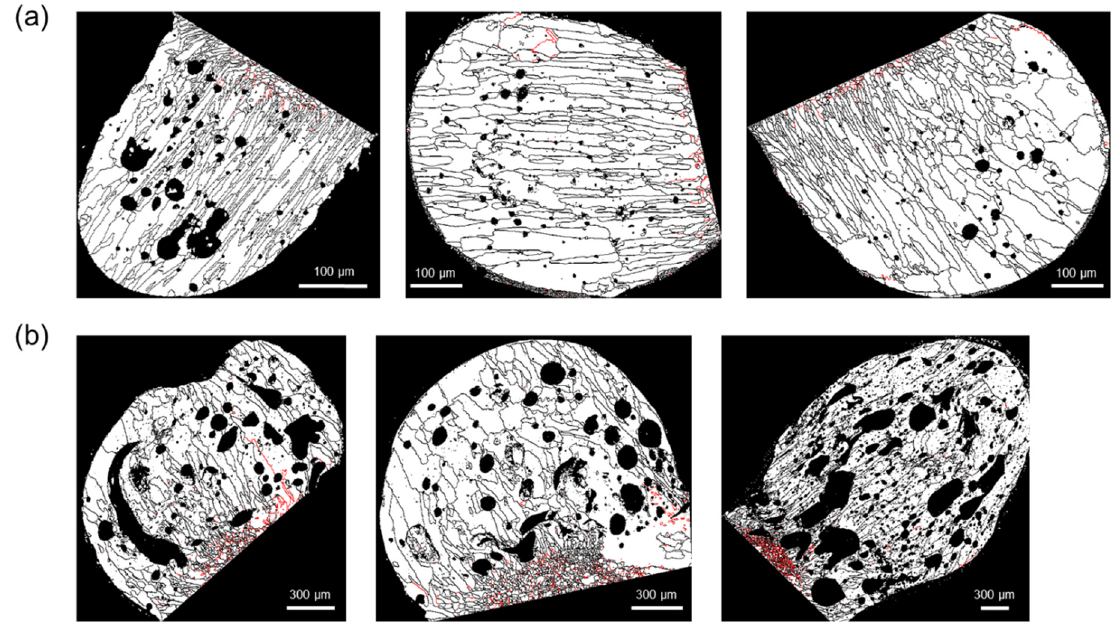
Figure 7. Distribution of Σ 3 boundaries (red line) in the molten marks: ( a ) PABs and ( b ) SABs.